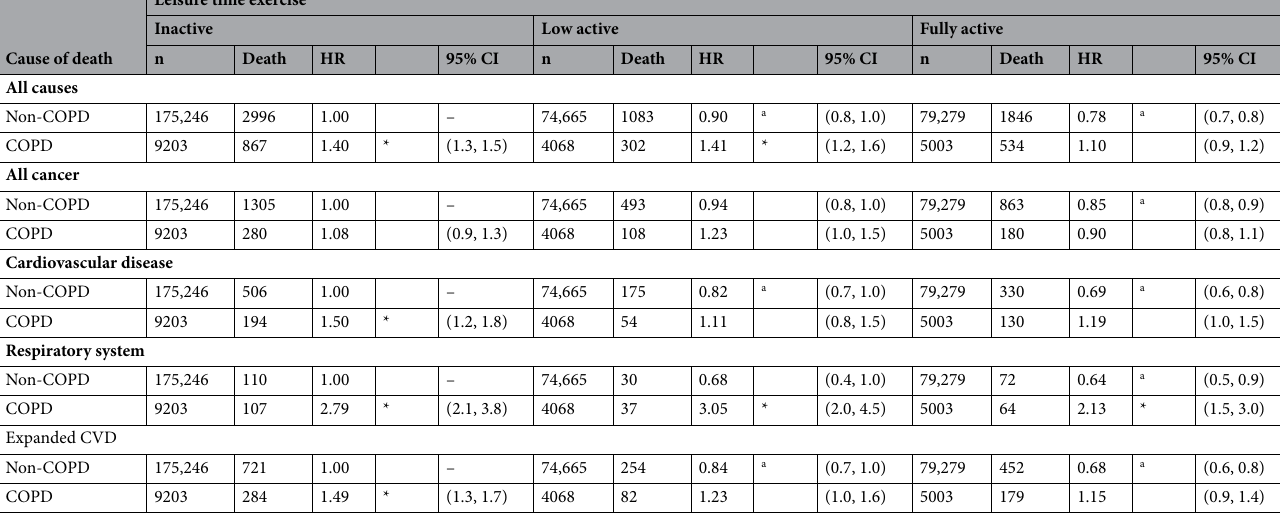
(Table A1) and reverse the systemic effect on CVD death, making exercise effective in patients with COPD. In addition, previous studies have indicated that exercise training can induce important adaptive and beneficial autonomic and cardiovascular adjustments, ensuring proper blood perfusion of peripheral tissues according to metabolic demands 27,28 . Interestingly, our study provides evidence in support of exercise ‐ induced neuronal